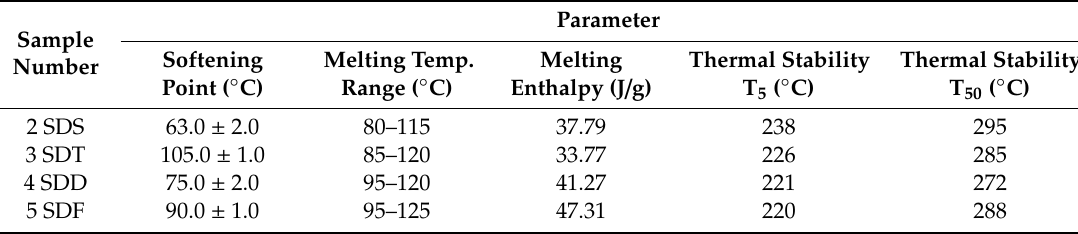
Table 3. Thermal parameters of sulfur–organic